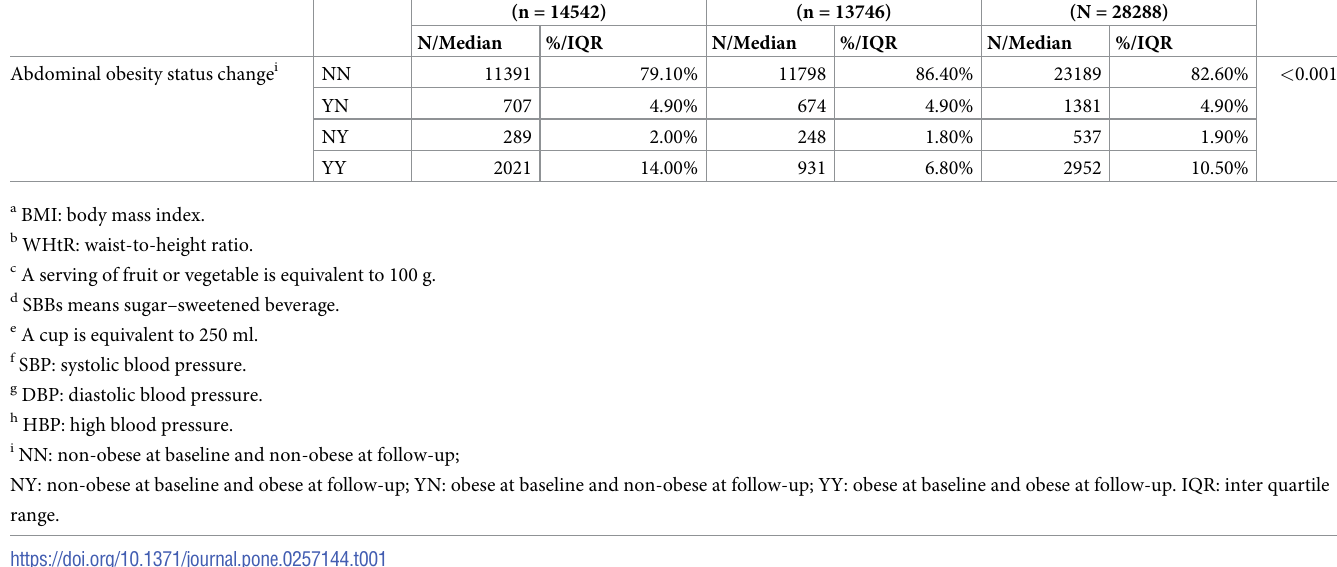
at baseline and 8.8% at the follow-up survey (12.6% vs 4.7% for boys and girls, respectively, S2 Table). At the follow-up survey, 10.3%, 12.4% and 5.8% of the participants had GOB, AOB and HBP, respectively. During the short-term follow-up period, for GOB, 86.9% of the children remained a non-GOB status, 9.4% of the children had persistent GOB, 2.8% converted from GOB to non-GOB, and 0.9% had newly developed GOB. Among the 3454 children with GOB at baseline, 77.2% of them had persistent GOB, and the conversion rate from GOB to non- GOB was 22.8% without intervention. While for AOB, 82.6% of the children remained a non-AOB status, 10.5% of the